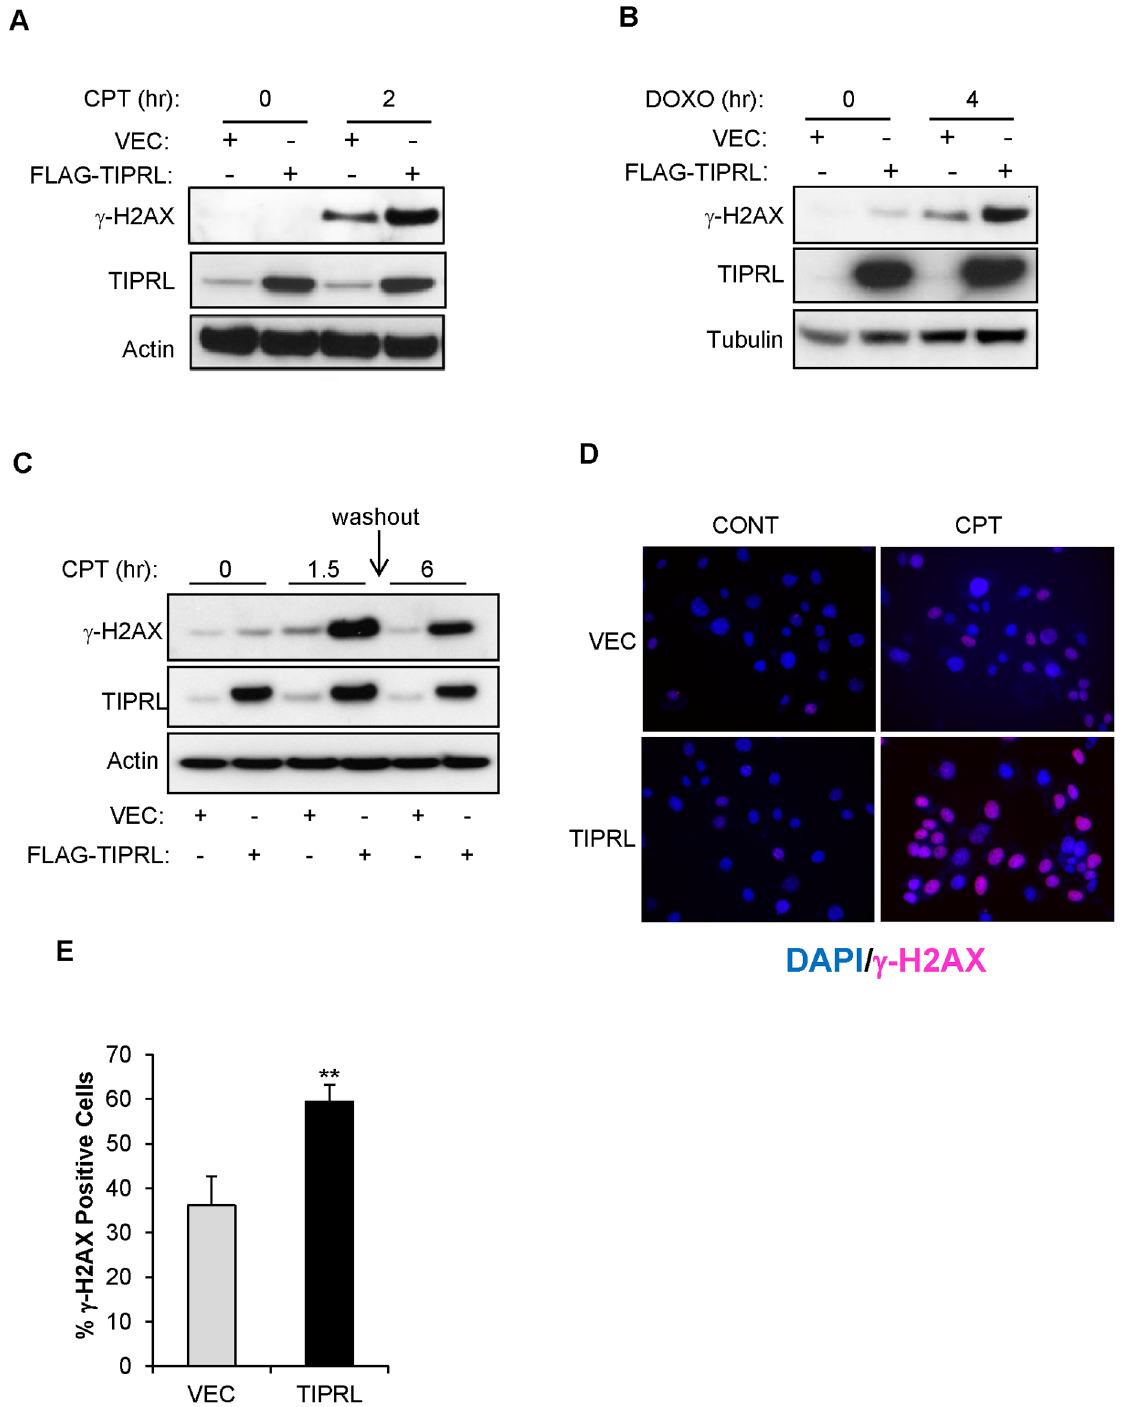
Fig 3. TIPRL promotes γ -H2AX phosphorylation in response to DNA damage. (A) HeLa cells were transiently transfected with vector control (VEC) or FLAG-TIPRL. 24hrs after transfection, cells were treated with CPT (2.5 μ M) or (B) doxorubicin (DOXO, 2 μ g/ml) for the indicated time points. Cells were lysed and immunoblots were probed with the indicated antibodies. (C) HeLa cells were transiently transfected with vector control (VEC) or FLAG-TIPRL. 24hrs after transfection, cells were treated with CPT (2.5 μ M) for 1.5h followed by washout for 6h. Cells were lysed and immunoblots were probed with the indicated antibodies. (D) 3T3 cells stably expressing LPC FLAG vector control (VEC) or LPC FLAG- TIPRL (TIPRL) were treated with 5 μ M CPT for 1.5hrs. Cells were fixed and stained for both DAPI and γ -H2AX and (E) images were quantified. Data represent ± standard deviation of the mean of three fields ** p < 0.01, Student ’ s t